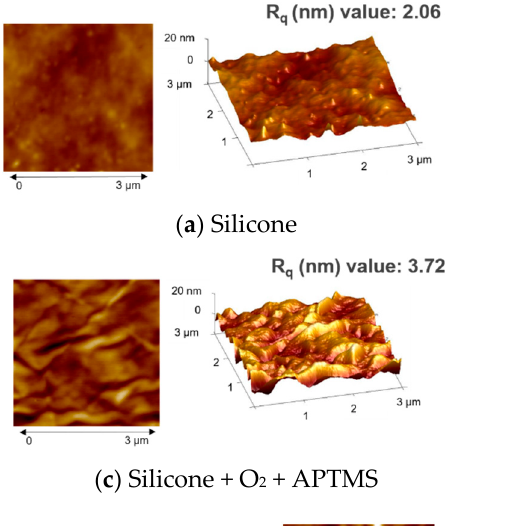
Figure 1. A schematic of IL-4 immobilization on a silicone implant. (i) O 2 plasma activation of the silicone surface; (ii) silanization using APTMS; (iii) introduction of a bifunctional linker using a bis-dPEG ® 13-NHS ester; (iv) IL-4 immobilization under basic conditions.